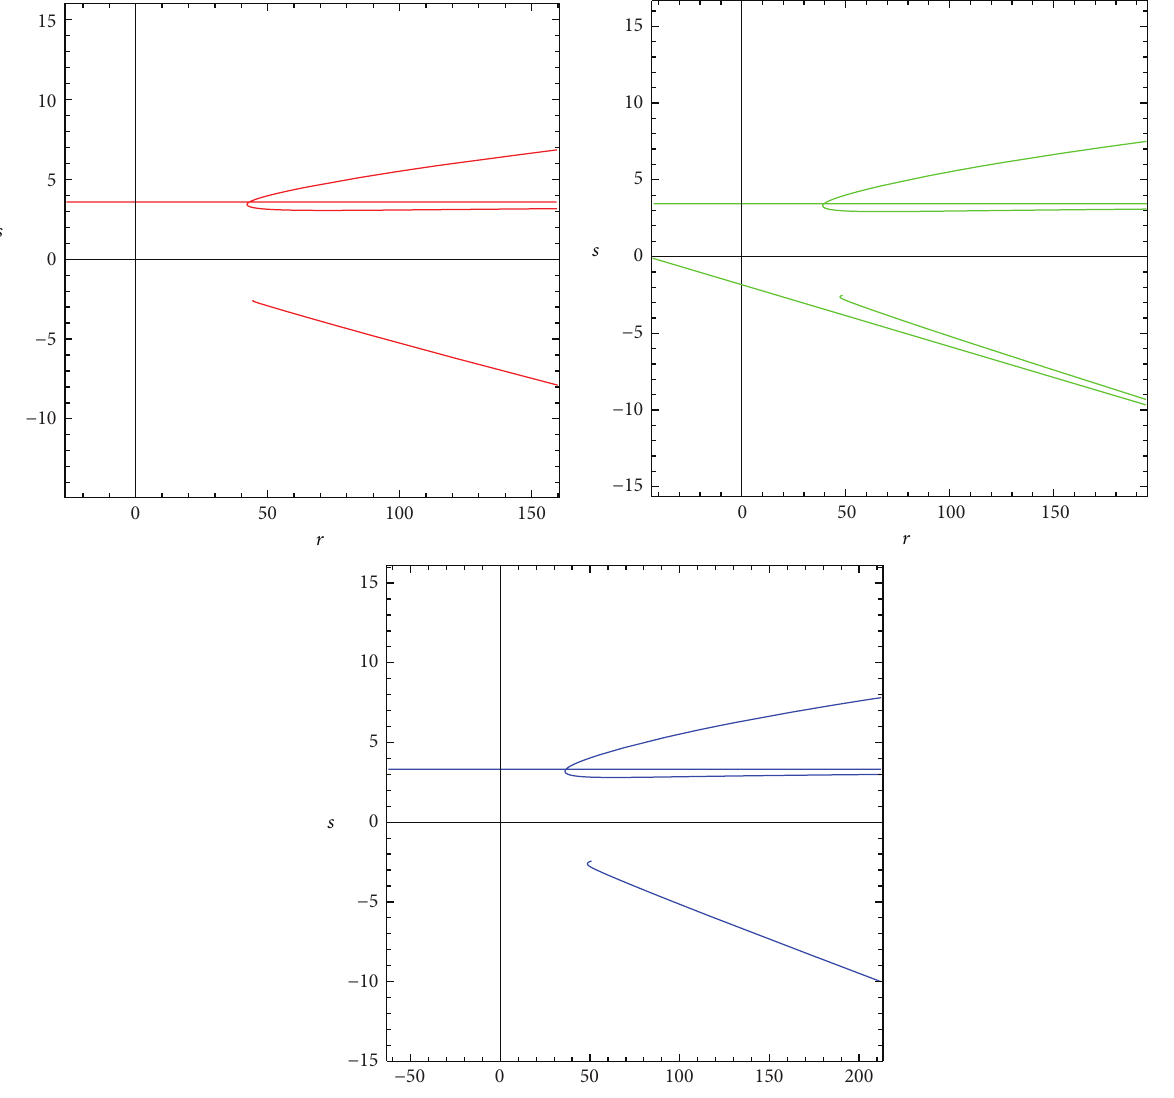
Figure 9: Trajectories of 𝑟 - 𝑠 for reconstructed PDE 𝑓(𝐺) model for 𝑢 = 2 with 𝑚 = 2 (red), 𝑚 = 2.2 (green), and 𝑚 = 2.4